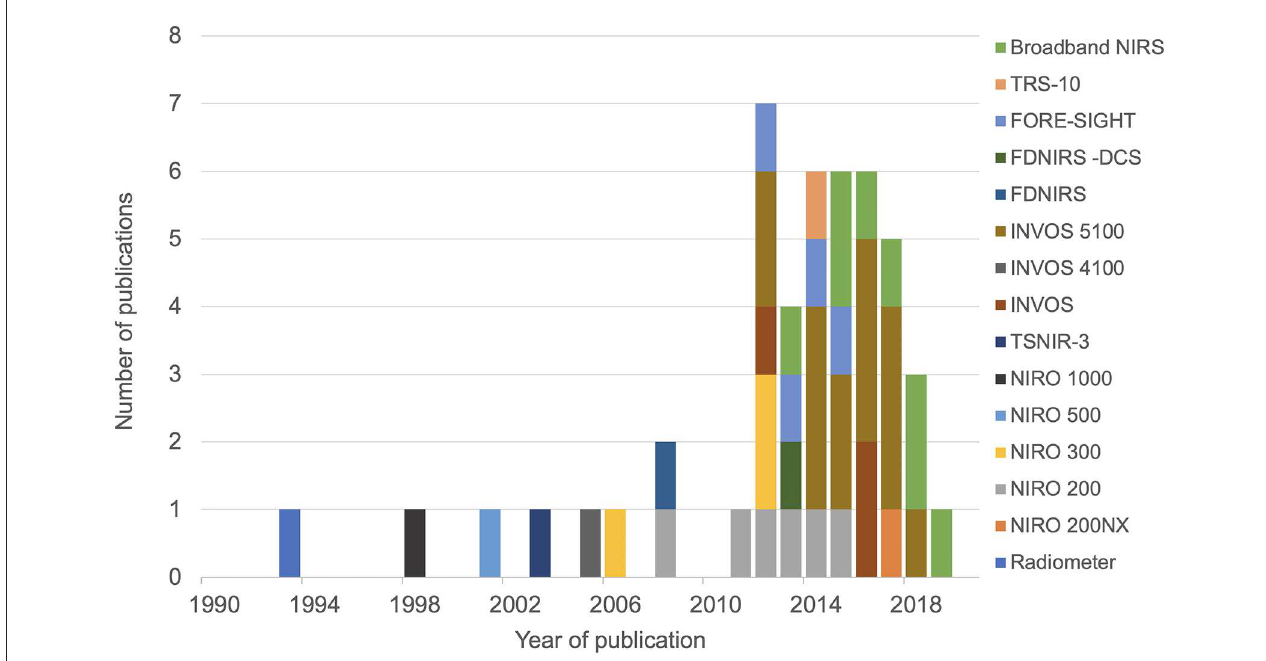
FIGURE 2 | Different NIRS devices used in the studies with their year of